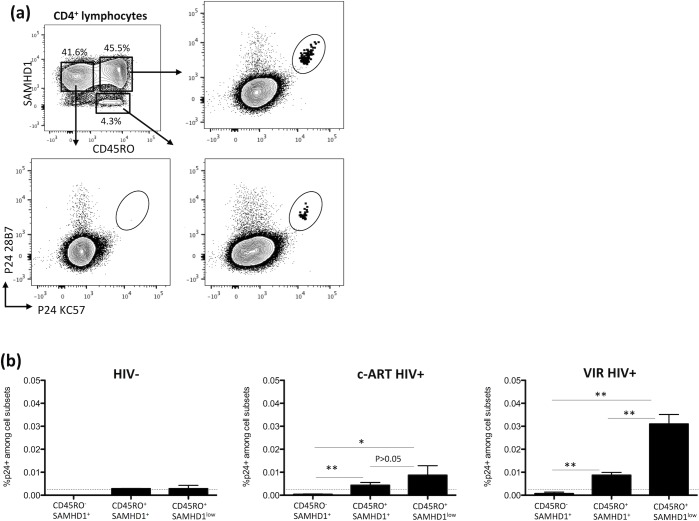
Detection of p24-producing cells in memory CD4+ CD45RO+ SAMHD1low, CD4+ CD45RO+ SAMHD1+ and naive CD4+ CD45RO- SAMHD1+ subsets.Samples from 3 viremic (VIR) and 7 c-ART individuals were used. 3 HIV-negative control were included. (a) Representative dot plots showing the p24 KC57-PE / p24 28B7-APC co-staining in purified CD4+ T cells stimulated with anti-CD3/CD28 antibodies for 48h. P24+ cells in memory CD4+ CD45RO+ SAMHD1low, CD4+ CD45RO+ SAMHD1+ and naive CD4+ CD45RO- SAMHD1+ subsets are shown (b) Frequencies of p24+ cells in each subset from c-ART and VIR HIV+ individuals are represented by histograms. Data represent median with interquartile range. Unpaired t test was applied for comparison between two subsets; *p<0.05, **p<0.01. Dotted-line points to the non-specific staining observed in HIV- individuals.